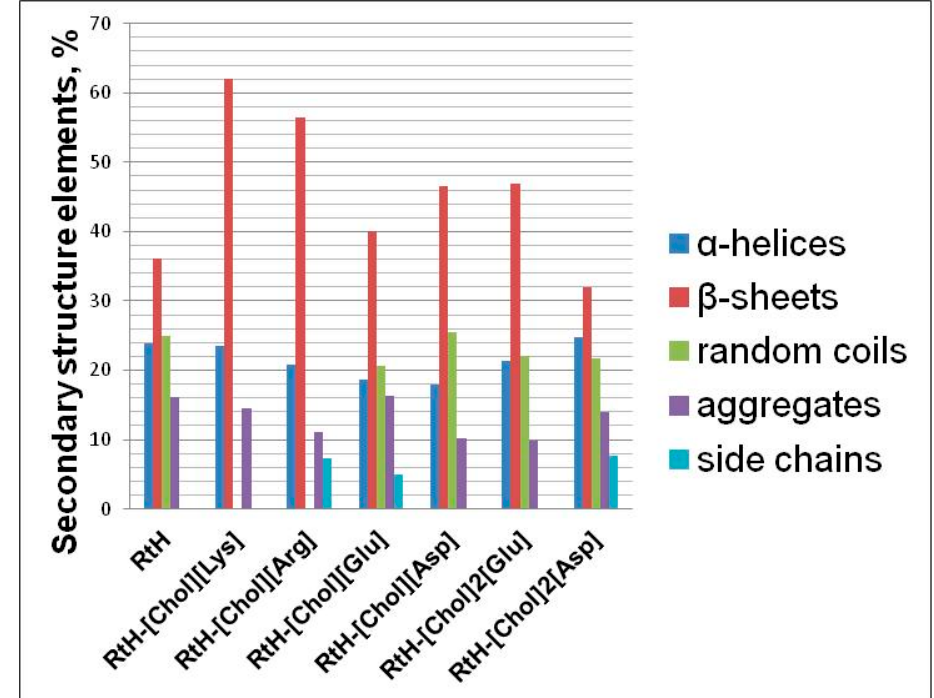
Figure 4. Conformational changes of RtH (30 mg/mL) in the presence of 0.2 M [Chol] n [AA] monitored by ATR-FTIR.